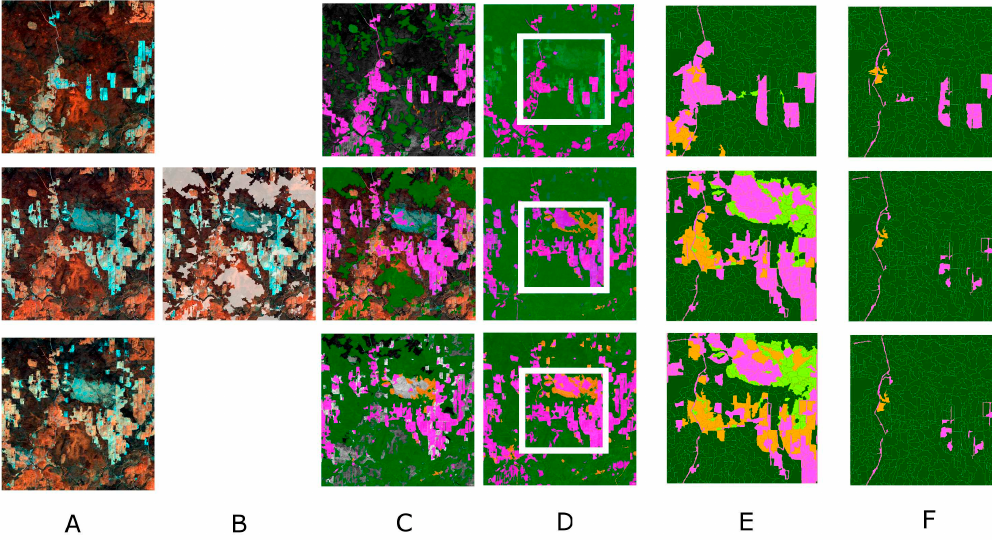
Figure 3. The multi-date processing scheme over the same area as in Figure 2 for year 1990 (top row), year 2000 (middle row) and year 2005 (bottom row) the following: ( A ) the 20 × 20 km Landsat imagery in colour composite b3,4,5; ( B ) the potential training objects (grey) for year 2000; ( C ) the training dataset after class labelling, where Dark green = Tree Cover, Orange = Other Wooded Land, and Pink = Herbaceous; ( D ) the final automated land cover classification, where Dark green = Tree Cover, Orange = Other Wooded Land, and Pink = Herbaceous; ( E ) the final, expert revised land cover classification of the central 10 × 10 km (corresponding to white box in D), where Dark green = Tree Cover, Light green = Tree Cover Mosaic, Orange = Other Wooded Land, and Pink = Herbaceous; and ( F ) the corresponding final, expert revised land use classification, where Dark green = Forest, Orange = Other Wooded Land, and Pink = Other Land Use.